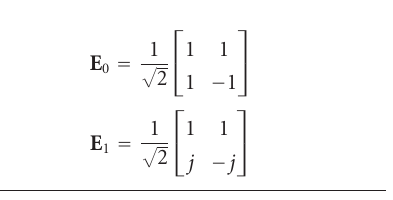
Table 1: Codebook size for unitary precoding, L =